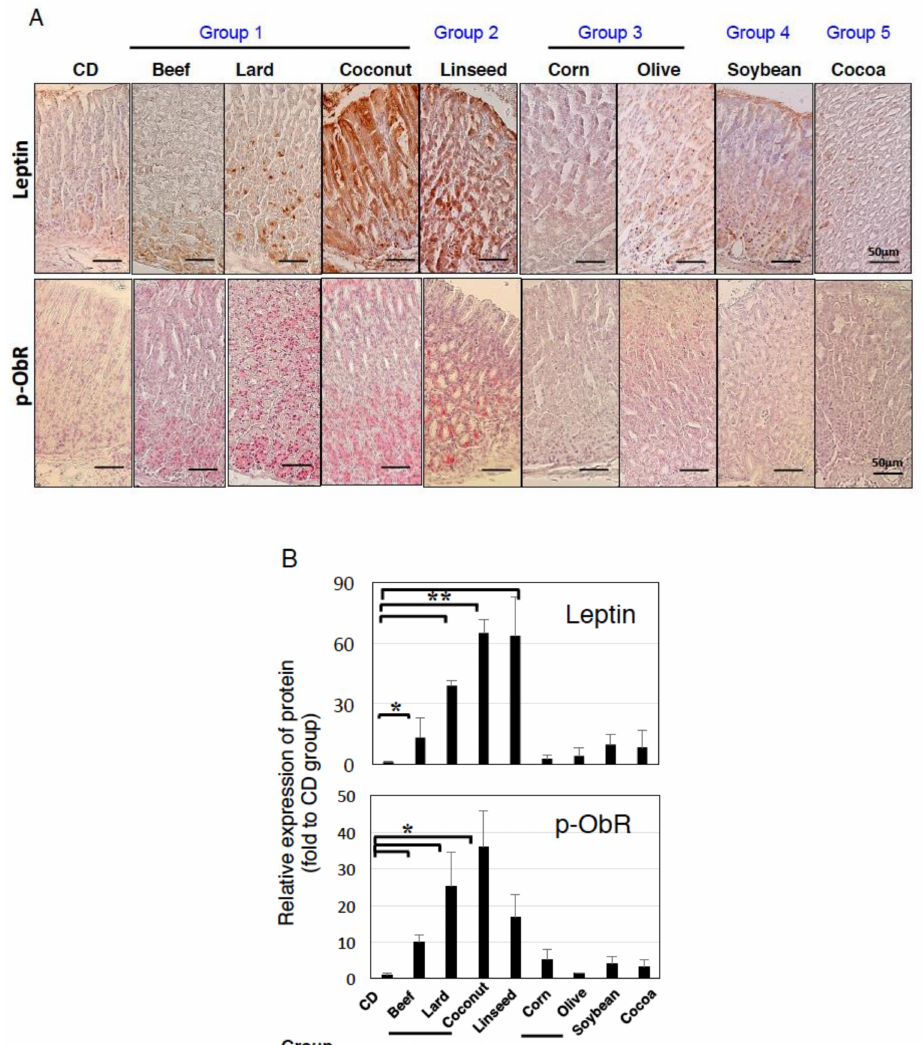
Figure 3. Di ff erence of leptin and phosphorylated ObR expression in the stomach owing to HFDs feeding. ( A ) Gastric sections stained for leptin and phosphorylated ObR in mice fed experimental diets for 12 weeks. ( B ) Quantification of leptin and p-ObR expression shown in Figure 3 was performed by using ImageJ software described in the Materials and Methods. Data, shown as mean ± SD of eight mice were analyzed by the one-way ANOVA followed by Holm-Sidak post-hoc test for multiple comparisons. * p < 0.05, ** p <